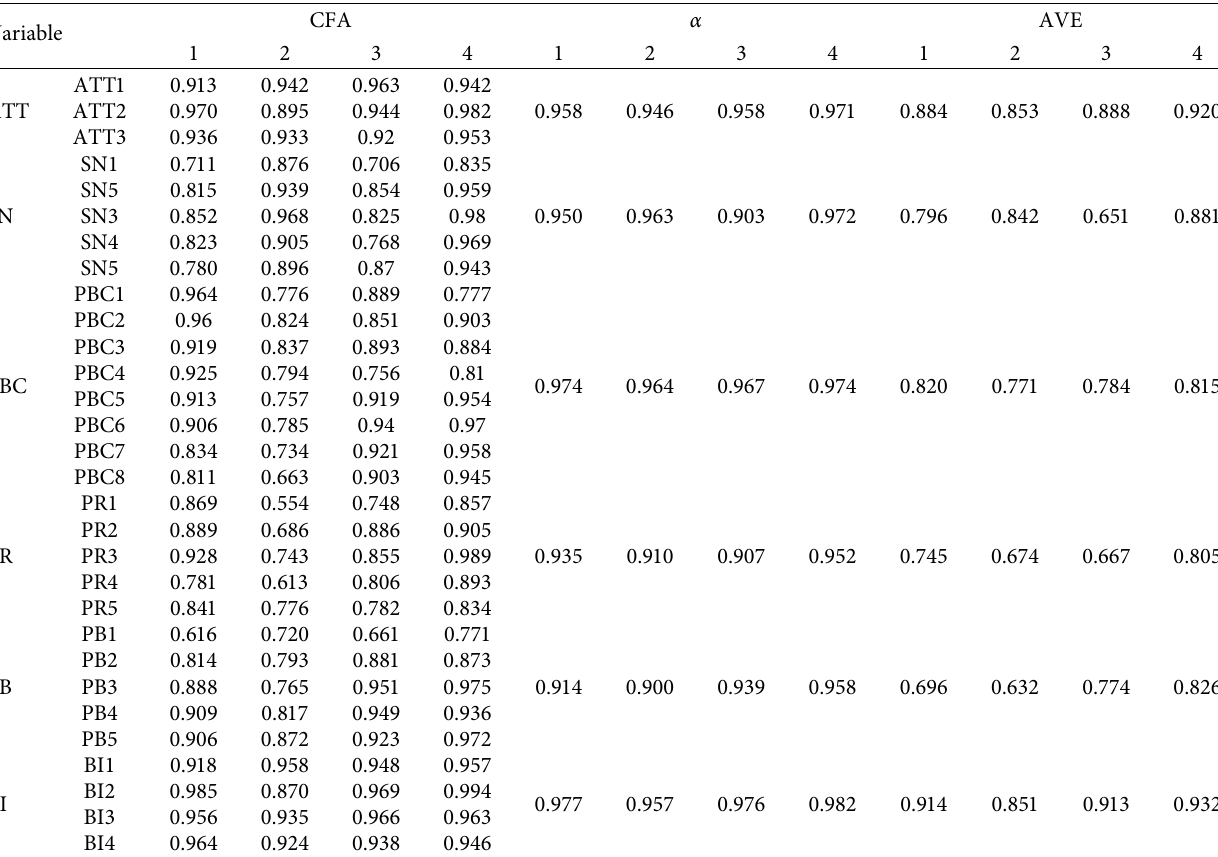
Table 4: Reliability and validity test results.